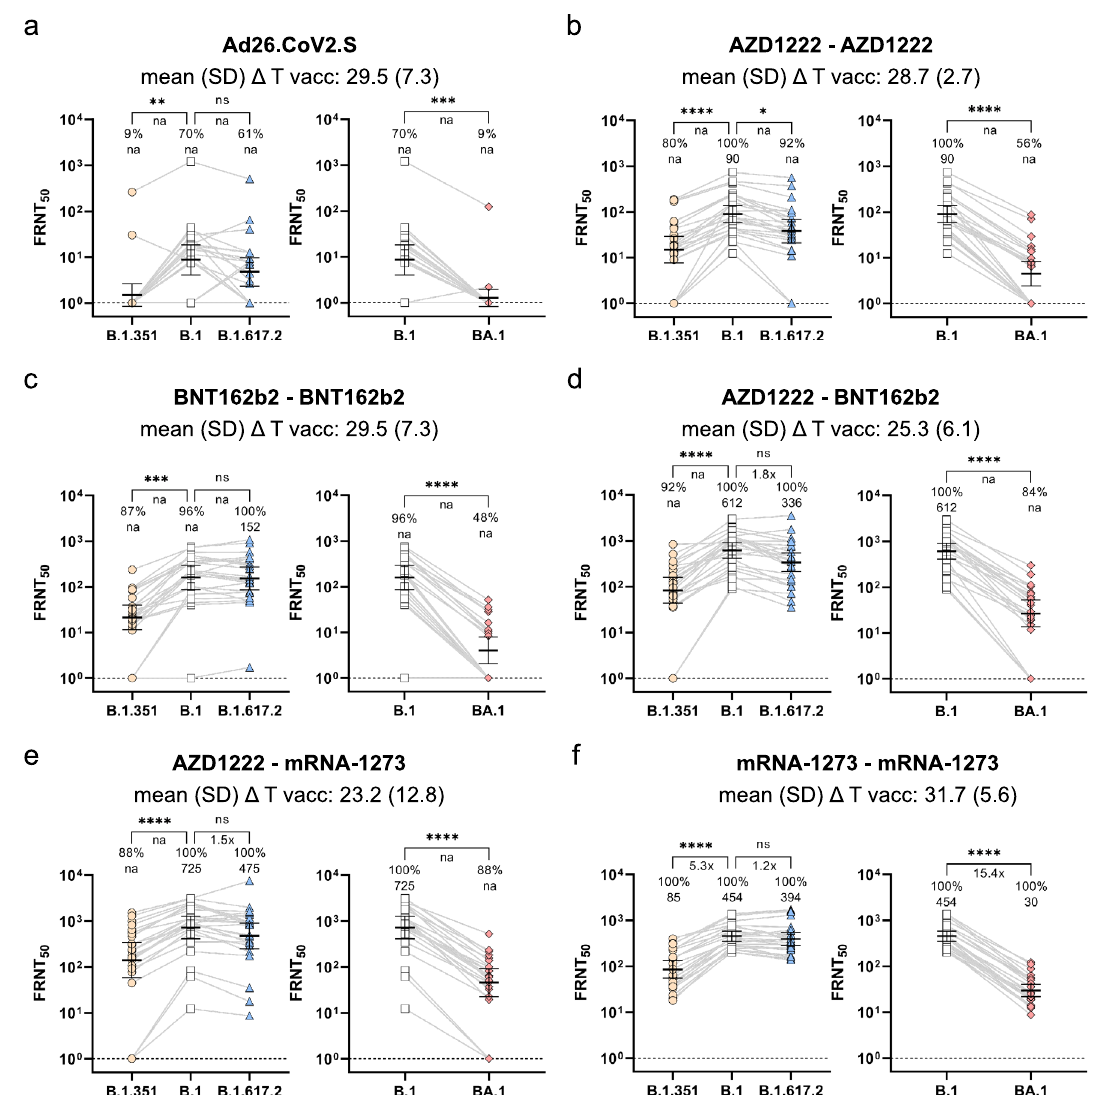
Figure 1. Impact of SARS-CoV-2 vaccination schemes on neutralization response towards the Omicron BA.1 variant. Vaccination-induced neutralization potency against Omicron (BA.1), Beta (B.1.351), Delta (B.1.617.2) or Wuhan (B.1) pseudotypes was measured in individuals who received a vector-based vaccination with single dose Ad26.CoV2.S (n = 23, a ), two doses of AZD1222 (n = 25, b ), two doses of mRNA vaccine BNT162b2 (n = 23, c ), a heterologous two-dose vaccination with AZD1222-BNT162b2 (n = 25, d ) or AZD1222- mRNA-1273 (n = 24, e ), or two doses of mRNA vaccine mRNA-1273 (n = 24, f ) after the indicated time periods following the last dose. FRNT 50 data is expressed for each serum sample, bold horizontal lines and whiskers are geometric means with 95% CI. Interconnecting lines represent sample data from the same donor. Non- neutralizing sample values were arbitrarily set to 1 for presentation purposes, indicated by a dashed line. Fold change in neutralization potency between SARS-CoV-2 B.1 and VoC pseudotypes is shown below p -values. Percentage (%) responder rates and FRNT 50 geometric mean titers (GMT) per SARS-CoV-2 pseudotype are shown above the individual measurements. Fold-change in neutralization potency and GMTs for SARS-CoV-2 pseudotypes are only calculated for groups where all samples had a detectable neutralizing activity, or else not applicable (na) is stated. Time between sampling and full vaccination in days is displayed as mean and SD below the vaccination scheme. Statistical analysis was performed by paired non-parametric Friedman’s test followed by a Dunn’s multiple comparison analysis. Statistical significance was defined by a value of * < 0.05; ** < 0.01; *** < 0.001; **** <